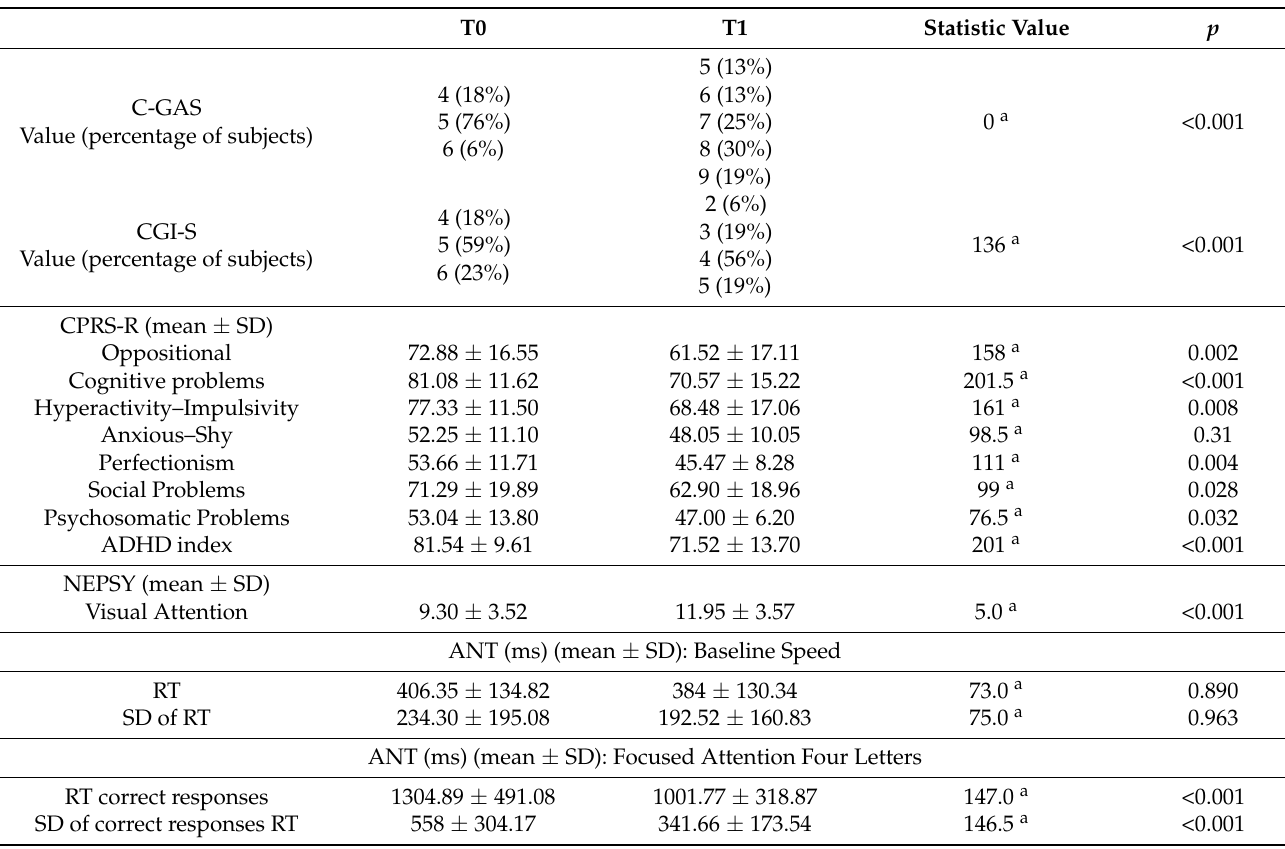
Table 2. Repeated-measures analyses results. Clinical, neuropsychological, and neurophysiological characteristics of the sample before and after the